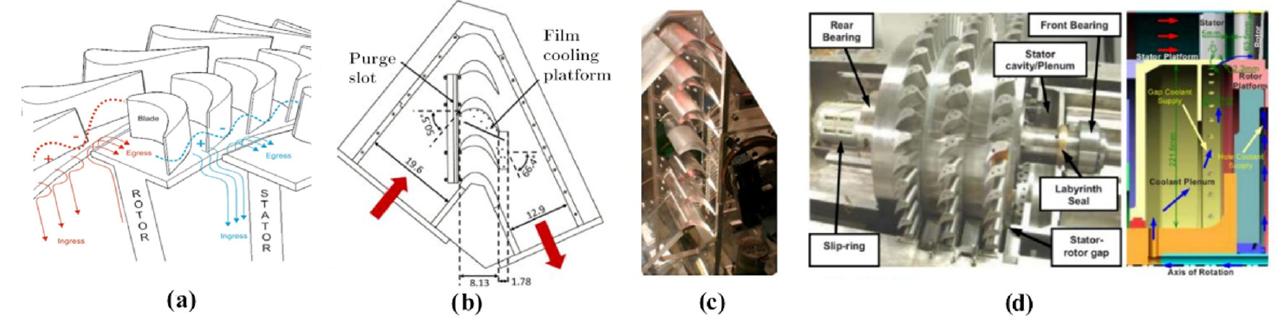
Figure 1. Linear and rotating cascades examples: ( a ) Sketch of rotor platform cooling flows [39] ( b ) Five blade rotor cascade [16], ( c ) Seven blade rotor cascade [24,25], ( d ) Turbine rotor component with stator cavity and labyrinth seal of TPFL [29,30].